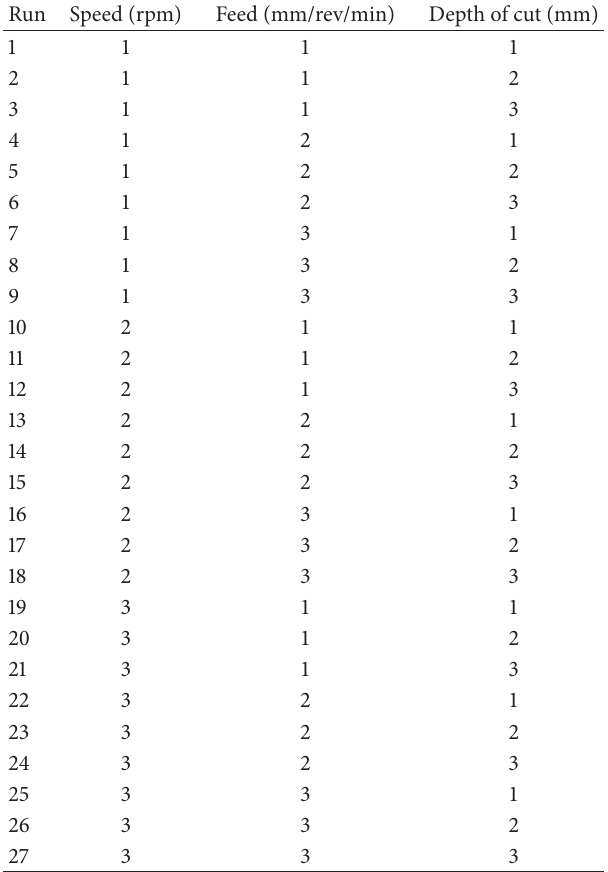
Table 3: DOE trials OF